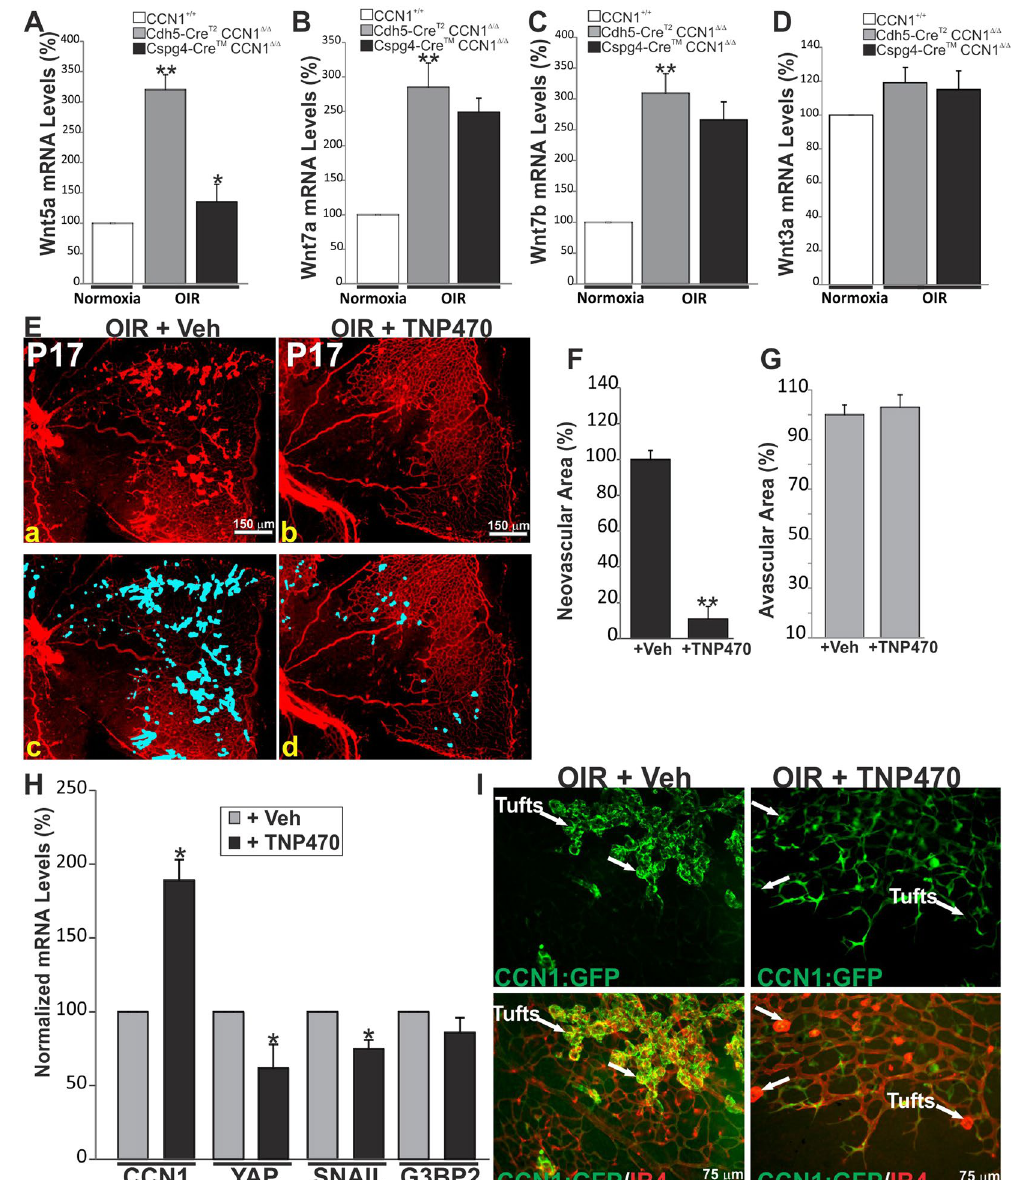
Figure 7. Inhibition of non-canonical Wnt5a reduced pathological neovascularization following OIR. ( A – D ) Expression of Wnt5a, Wnt7a, Wnt7b and Wnt3a in mice with either endothelial- or pericyte-specific CCN1 deletion and their wild-type littermates following OIR. Wnt ligand gene expression was analyzed by qPCR in retinal lysates harvested at P17. ** p < 0.01 versus CCN1 + / + . * p < 0.01 versus Cdh5-CreER T2 CCN1 Δ / Δ . ( E–G ) Flat-mount images of IB4-stained retinas from OIR mice at P17 following treatment with either TNP470 or vehicle alone (Veh). Areas of pre-retinal neovascular tufts at P17 were delineated by a computer-assisted image software and highlighted in blue (c for a and d for b). The compiled data showing the percentage of neovascular and avascular areas are represented in F and G. ** p < 0.05 versus + Veh. ( H ) Transcript levels of CCN1, YAP, SNAIL and G3BP2 as determined by qPCR in retinas from OIR mice injected with either control vehicle or TNP470. RNA levels at P17 ( + Veh) were set to 100% to facilitate comparison among groups. * p < 0.01 versus P17 ( + Veh). ( I ) Retinal flat-mounts from OIR CCN1:GFP reporter mice treated with vehicle or TNP470. Note that TNP470 treatment resulted in reduced neovascular tuft formation and reexpression of the CCN1:GFP reporter in ECs instead of perivascular pericytes in remnant tufts